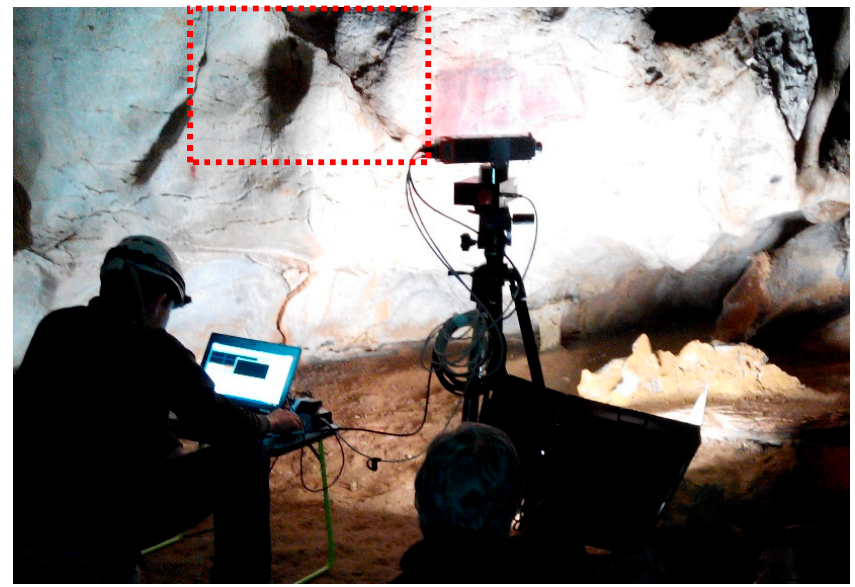
Figure 2. View of the decorated panel and the hyperspectral setup in the Cave of El Castillo (authorized by GIM Geomatics, S.L.).